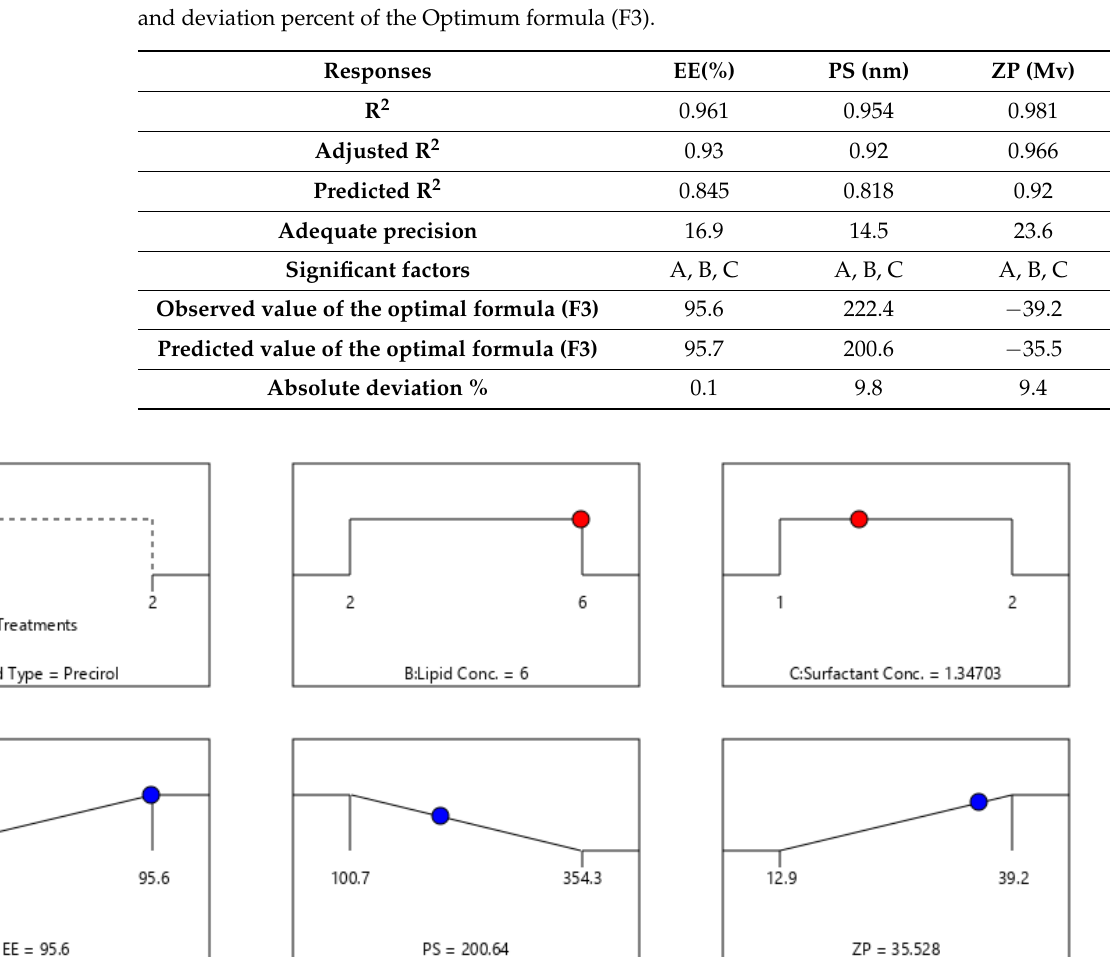
Figure 14. Optimization ramps for the examined independent variables utilize the optimal criteria of the formulation variables for 4h-loaded NLC formulas with the projected value of each measured formulation parameter.